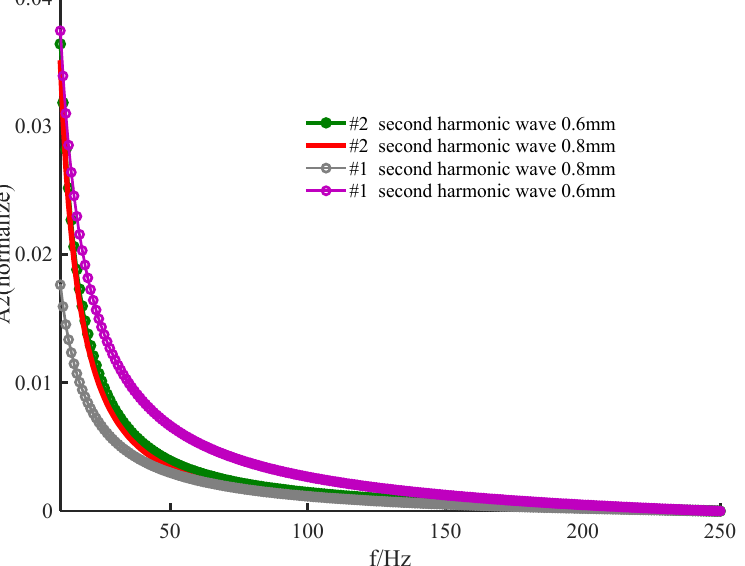
Figure 6. Variation in the fundamental frequency wave and second harmonic with frequency.